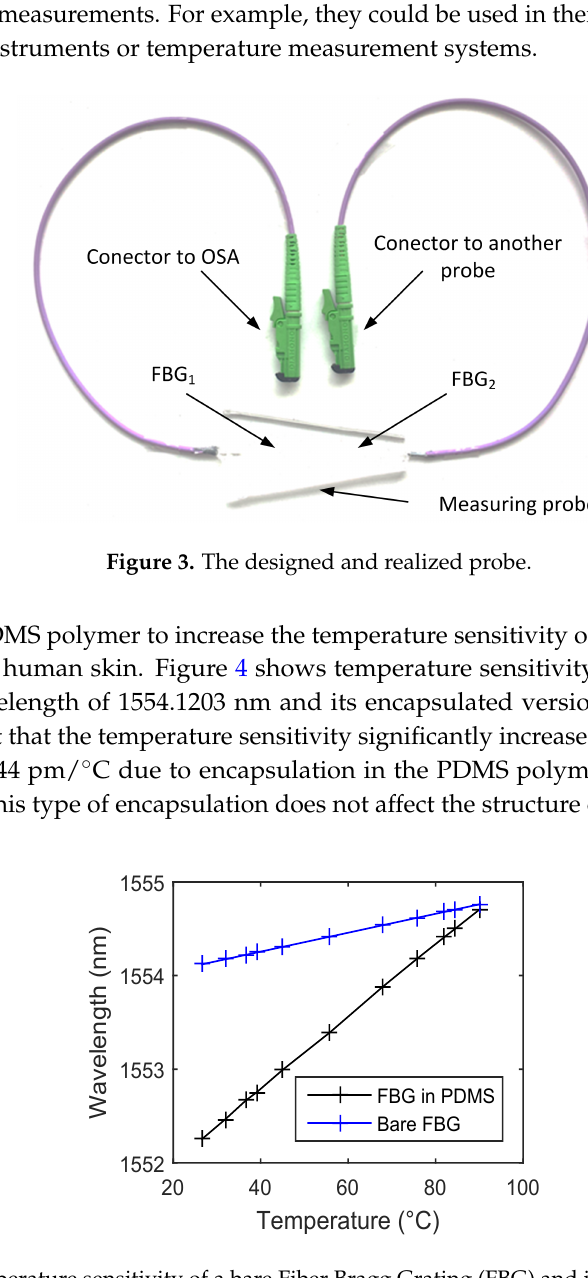
Figure 4. The temperature sensitivity of a bare Fiber Bragg Grating (FBG) and its encapsulated version inside the polydimethylsiloxane (PDMS)